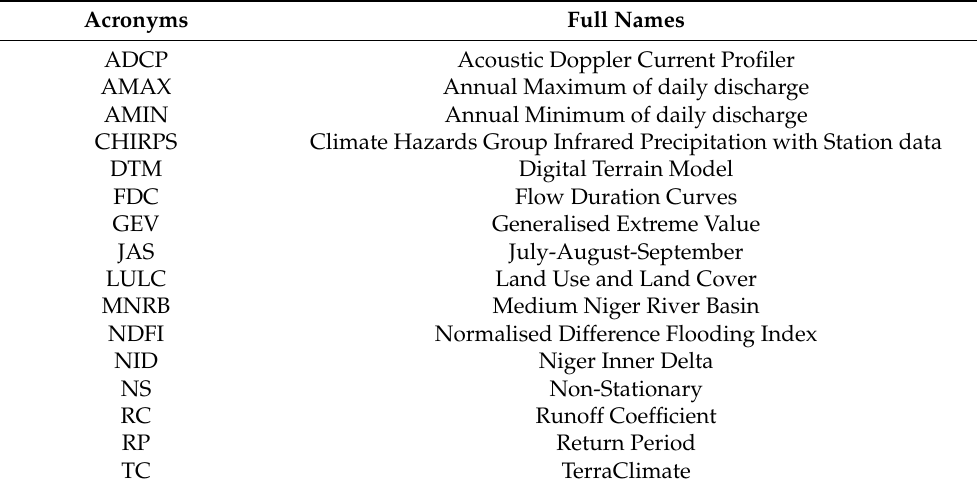
Table 1. The glossary of acronyms used in the text (acronyms of climatic indices are exposed in Table